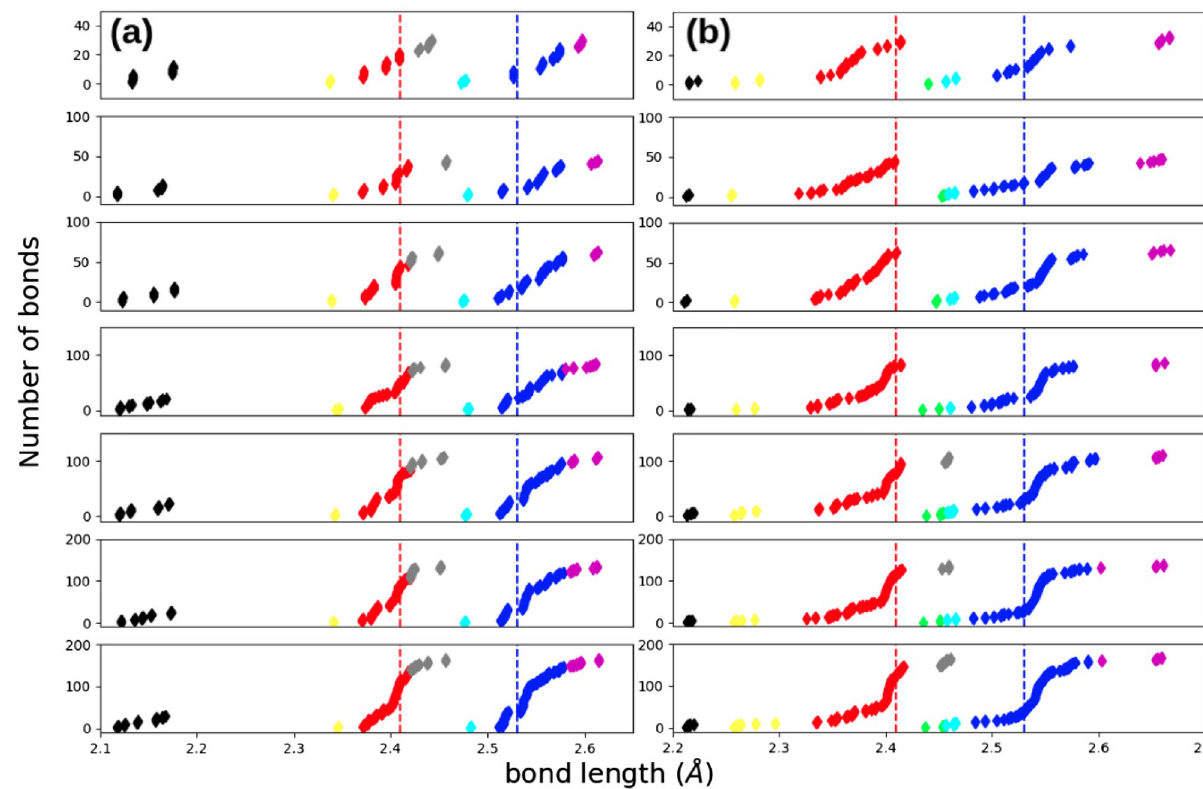
Figure 4. Bond distance distribution for the stablest S/Se terminated configurations. ( a ) C1(n) with n = 4–10 from top to bottom, and ( b ) C2(n) with n = 4–10 from top to